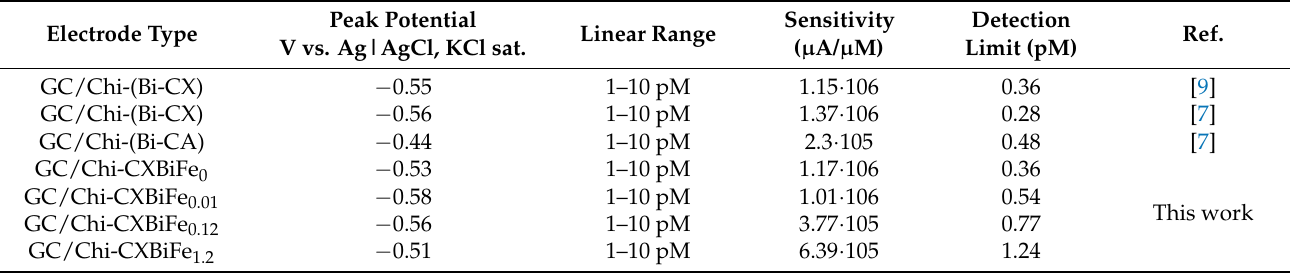
Table 6. Linear regression parameters for SWASV detection of Pb 2+ at CXBiFe x nanocomposites modified glassy carbon electrodes. Table 7. Analytical parameters of the sensors based on carbonaceous materials used for SWASV detection of Pb 2+ . Peak Potential Electrode Type V vs. Ag|AgCl, KCl